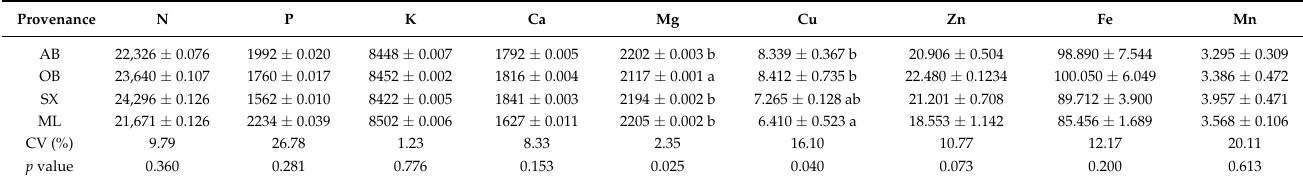
Table 5. Variation in seed mineral concentrations among four X. sorbifolium provenances (mg/kg; dry weight).